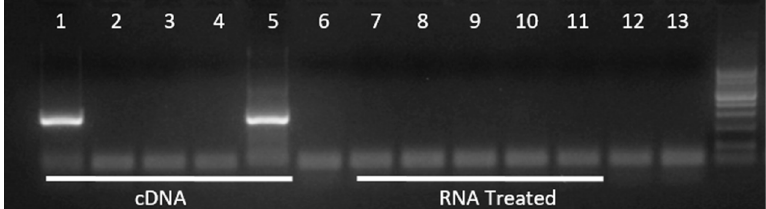
Figure 2. Detection of BLV (bovine leukemia virus) tax gene by nested-PCR. Amplification of cDNA obtained by retrotranscription (RT) reaction from isolated and treated RNA; each treated RNA sample